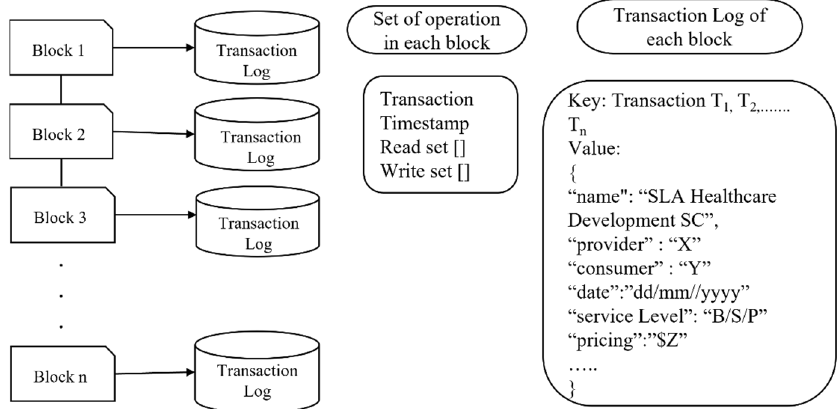
Figure 6. The transactions log is monitored to check vulnerabilities.